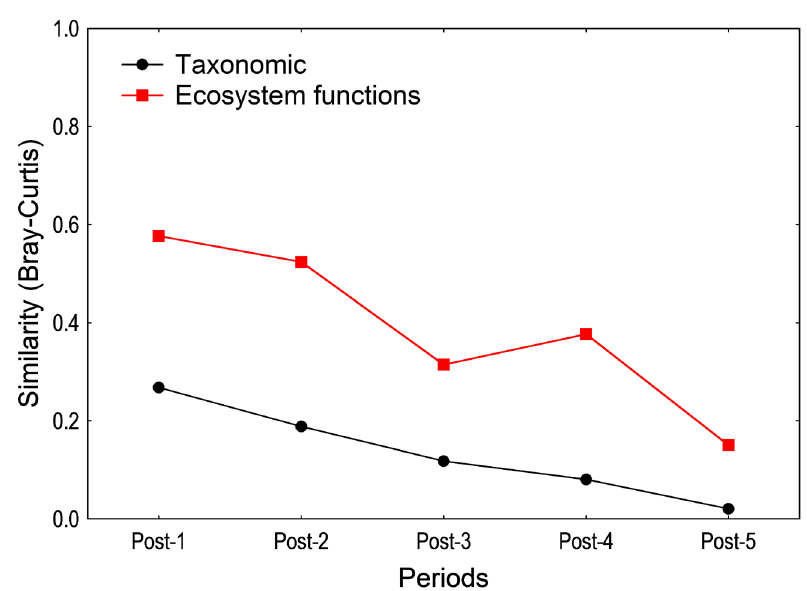
FIGURE 4 | Temporal decay of taxonomic and functional similarity (Bray Curtis, biomass-based) during the study period, calculated as the composition similarity of the Pre period against each Post period.